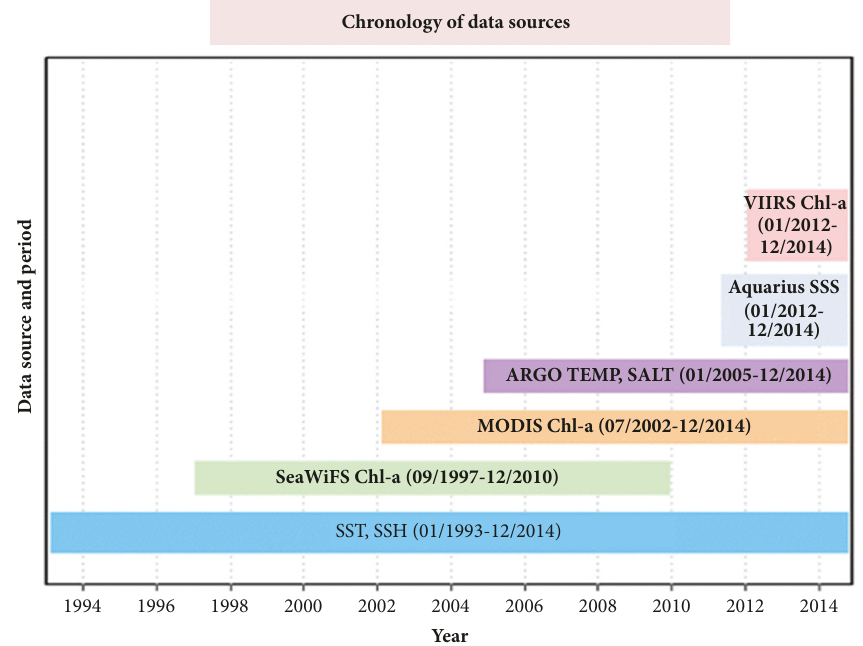
Figure 1: Satellite and in situ data available for NN training and validation.